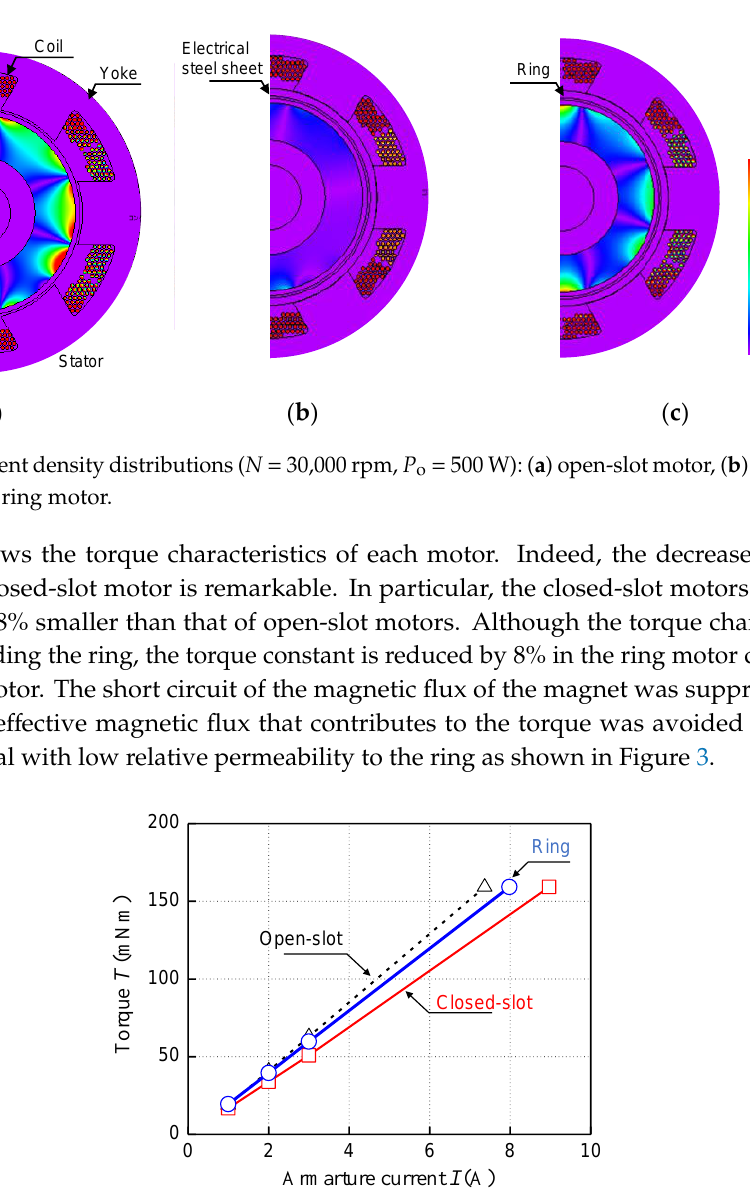
Figure 9. Thrust characteristics.